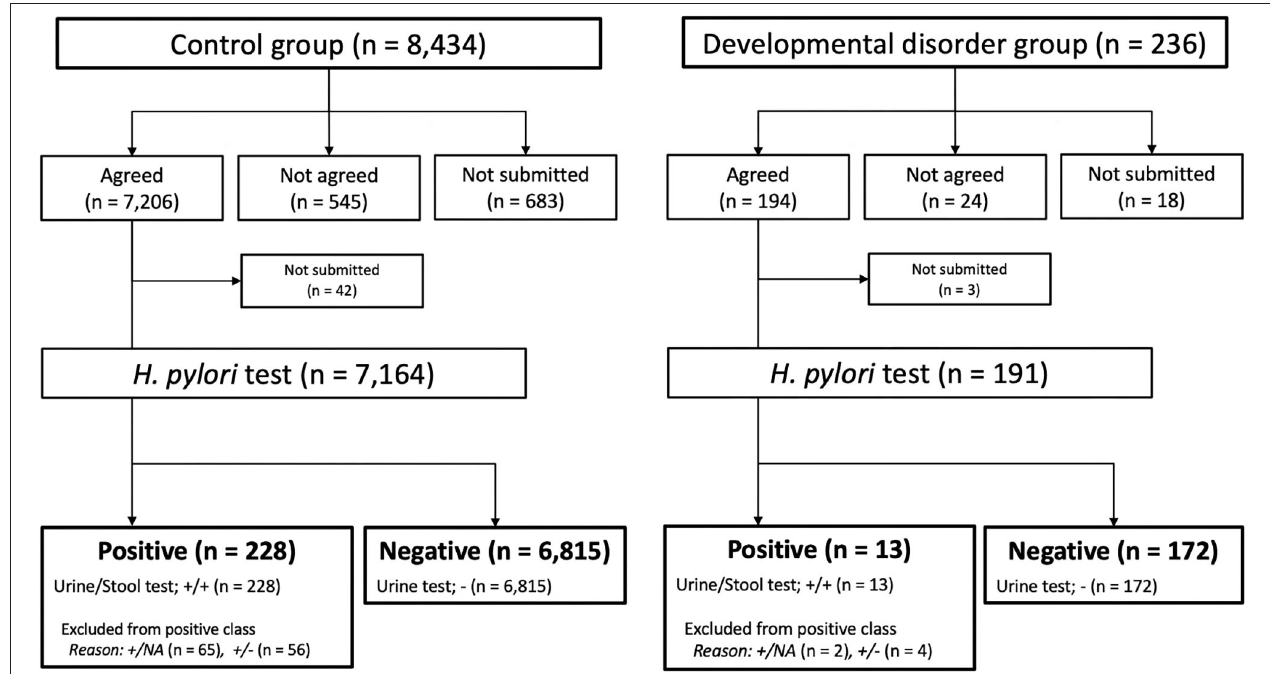
FIGURE 1 | Participant’s flowchart and Helicobacter pylori test results. H. pylori , Helicobacter pylori ; NA, not